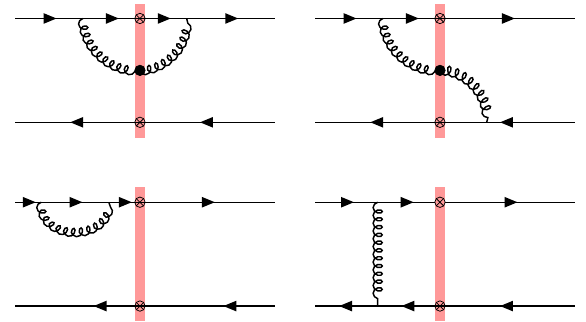
Figure 9. A subset of Feynman diagrams for the quantum evolution of the dipole correlator. Upper diagrams correspond to real gluon emission, while lower diagrams correspond to virtual